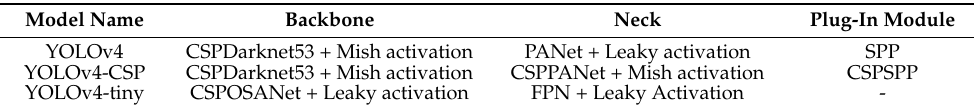
Table 3. Comparison of YOLOv4, YOLOv4-CSP and YOLOv4-tiny in terms of their architectural elements.